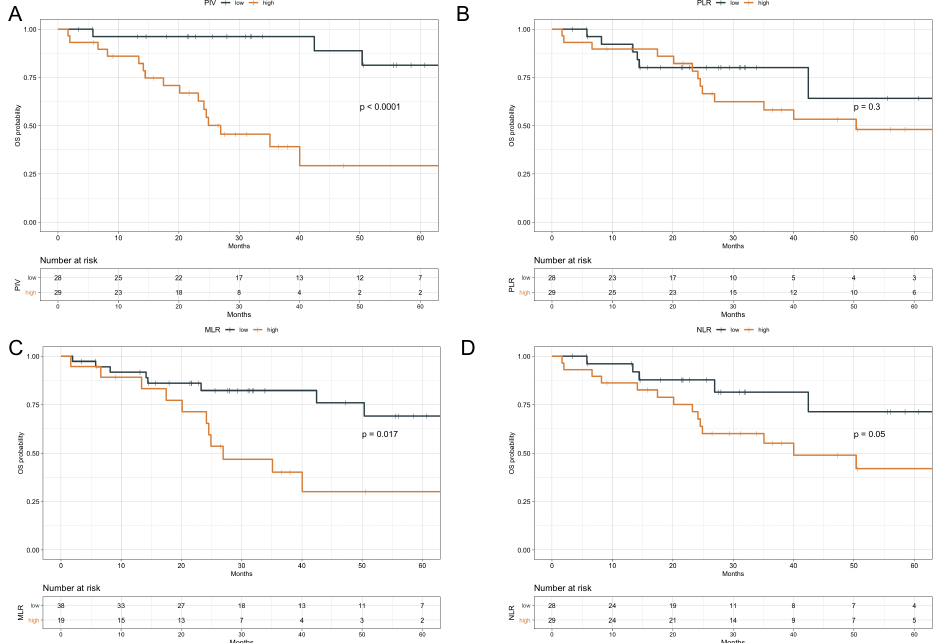
Figure 2. Overall Survival according to PIV, PLR, MLR, and NLR. Kaplan–Meier curves representing patient OS according to baseline PIV ( A ), PLR ( B ), MLR ( C ) and NLR ( D ) categories. The median value of each parameter was used as a threshold for the definition of the parameter categories (high vs. low). OS: Overall survival; PIV: Pan-Immune-Inflammation Value; MLR: monocyte to lymphocyte ratio; PLR: platelet to lymphocyte ratio. NLR: neutrophil to lymphocyte ratio. The I symbol indicates patients censored at the time of data cut off and